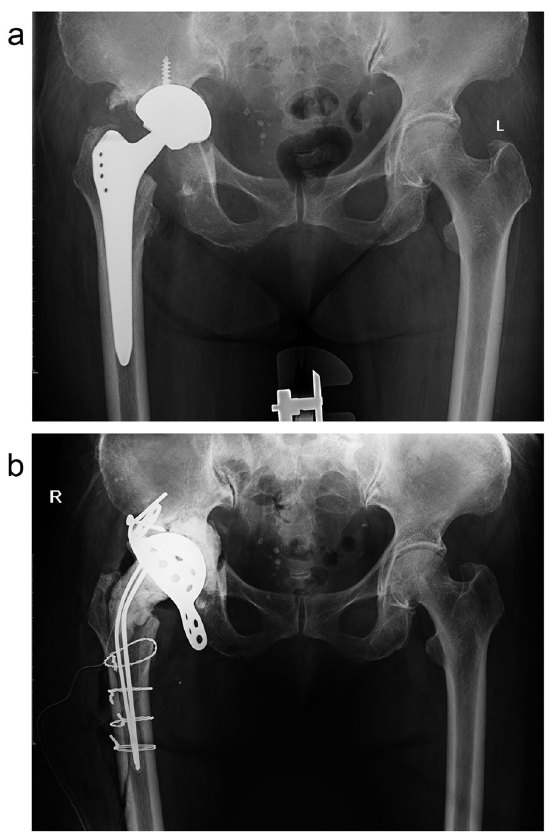
Fig. 4 A case of PJI with acetabular protrusion ( a ). Combination of a spacer and a cage to prevent central dislocation of the hip ( b )